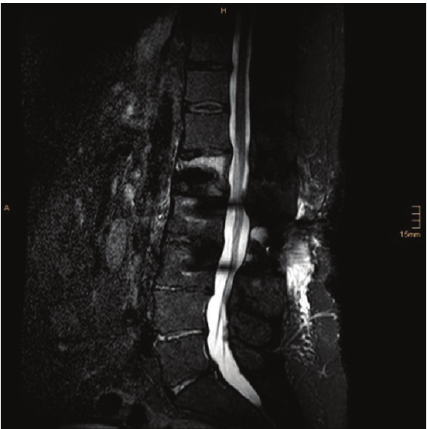
Figure 2: Postoperative sagittal MRI (STIR).